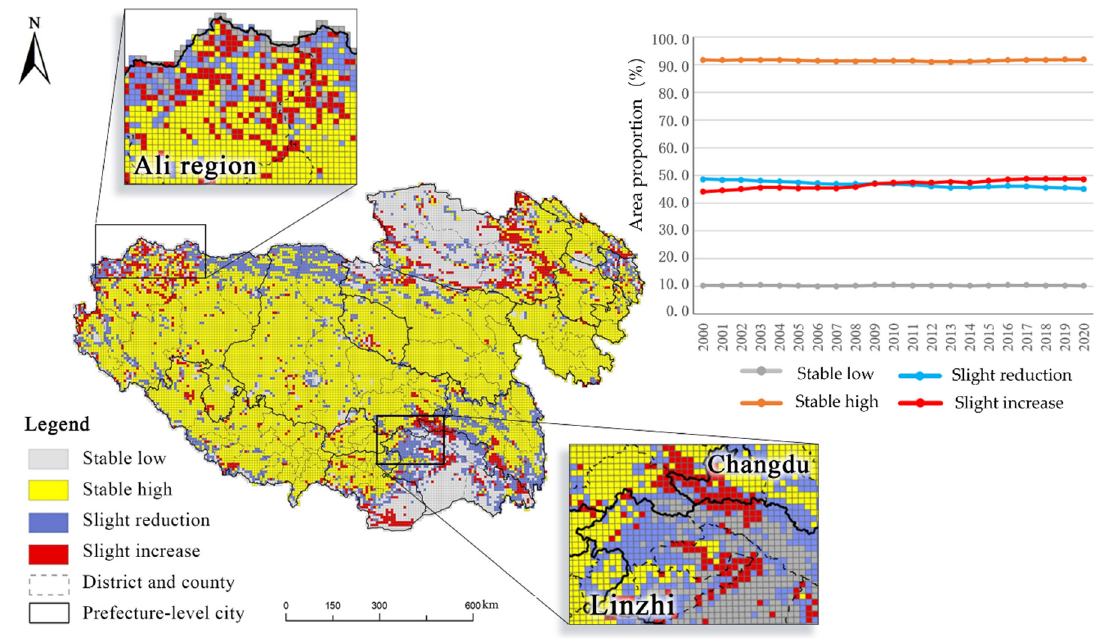
Figure 5. The evolution of the livestock pattern.